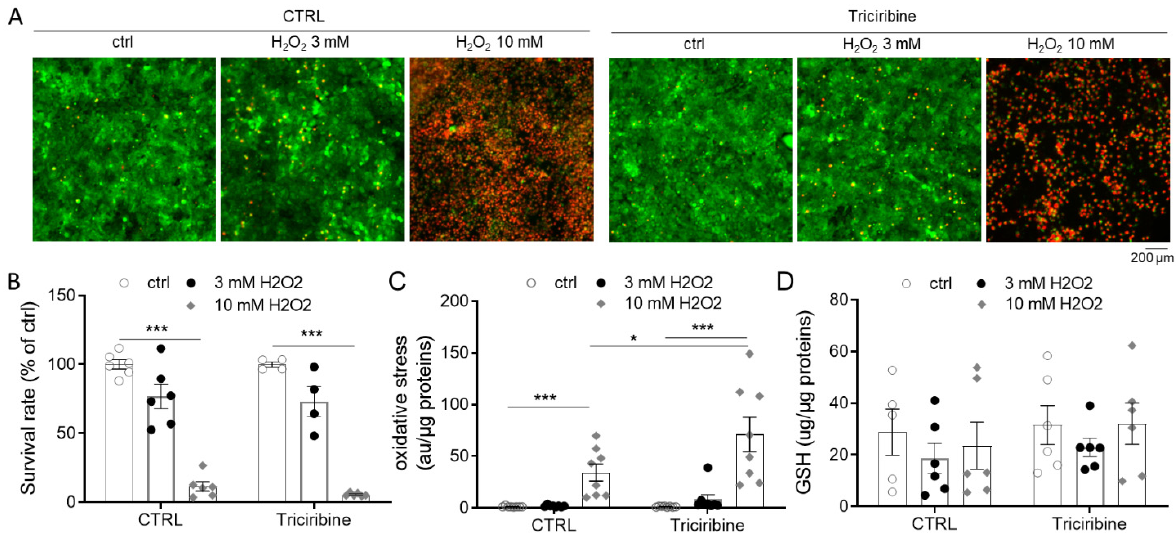
Figure 5. Effect of Akt inhibition on oxidative stress induced by hydrogen peroxide treatment. PCT cells treated or not for 24 h with triciribine (1 µM) and then treated with 3 or 10 mM H 2 O 2 for 24 h. ( A , B ) Cell viability was evaluated using a live/dead fluorescence assay on PCT cells treated. ( A ) Representative images for each condition with live (green, calcein-FITC) and dead (red, ethidium bromide homodimer) cells and ( B ) corresponding survival rate (live/dead cells). ( C ) Oxidative stress level was assessed by the addition of CMH2DCFDA probes. Fluorescence values were evaluated on cell lysate and normalized by protein content. ( D ) GSH content normalized by protein content. Scatter plot representation of individual values along with mean ± Sd. n = 4–6 ( B ), 8 ( C ) or 6 ( D ). * p < 0.05; *** p < 0.001.